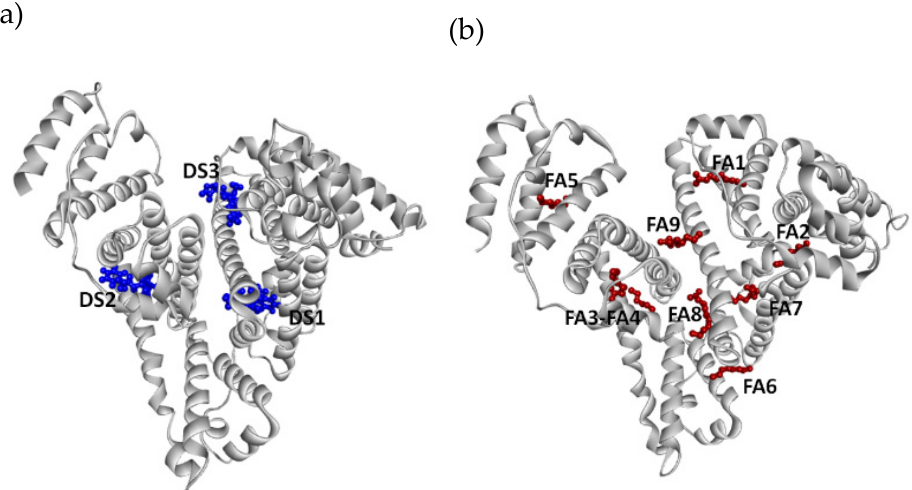
Figure 2. Sites of HAS protein interaction. ( a ) Sites for drugs. ( b ) Sites for fatty acids. (Source: PDB 1E7E [13]–modified).